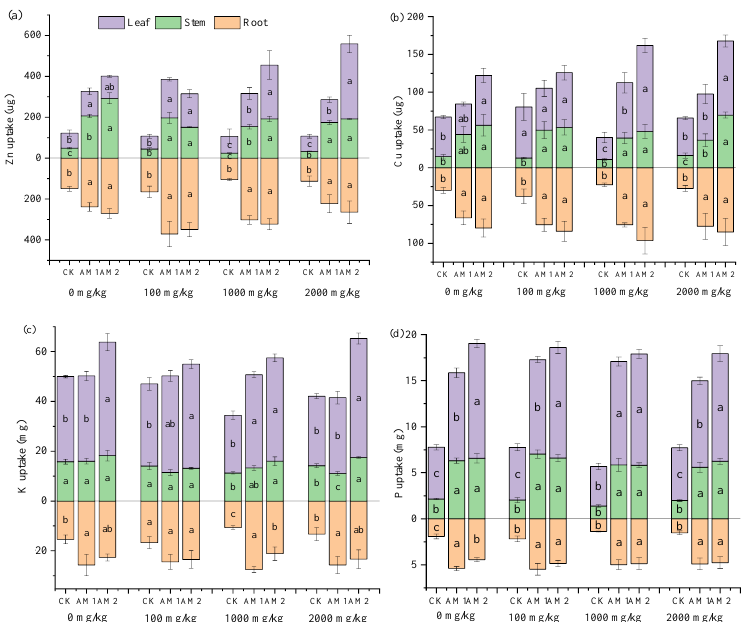
Figure 6. Shoot (above X -axis) and root (below X -axis) Zn ( a ), Cu ( b ), K ( c ), and P ( d ) uptake in maize plants at different Mo and AMF treatments. Vertical bars indicate standard deviations of the means ( n = 4). Different lowercase letters indicate significant differences under the different inoculation conditions at the same Mo addition level, determined using a one-way ANOVA followed by Duncan’s multiple range test ( p < 0.05).